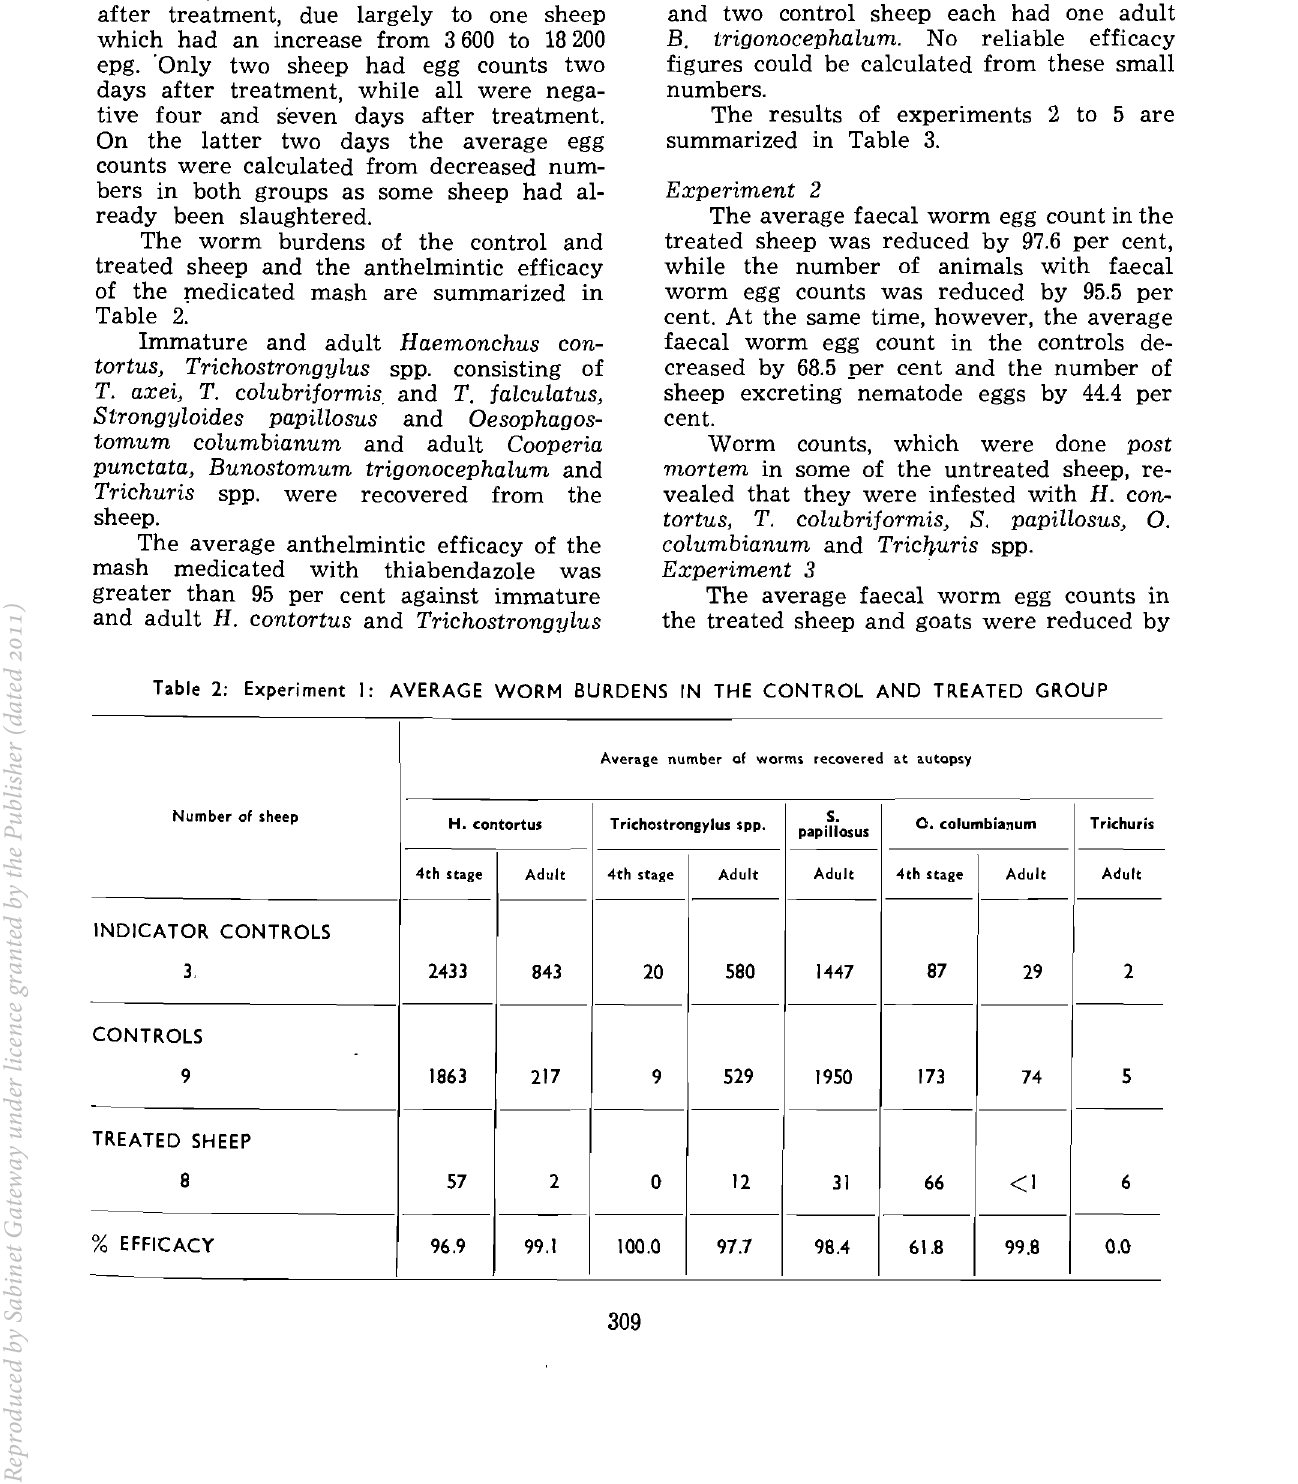
Table 2: Experiment I: AVERAGE WORM BURDENS IN THE CONTROL AND TREATED GROUP